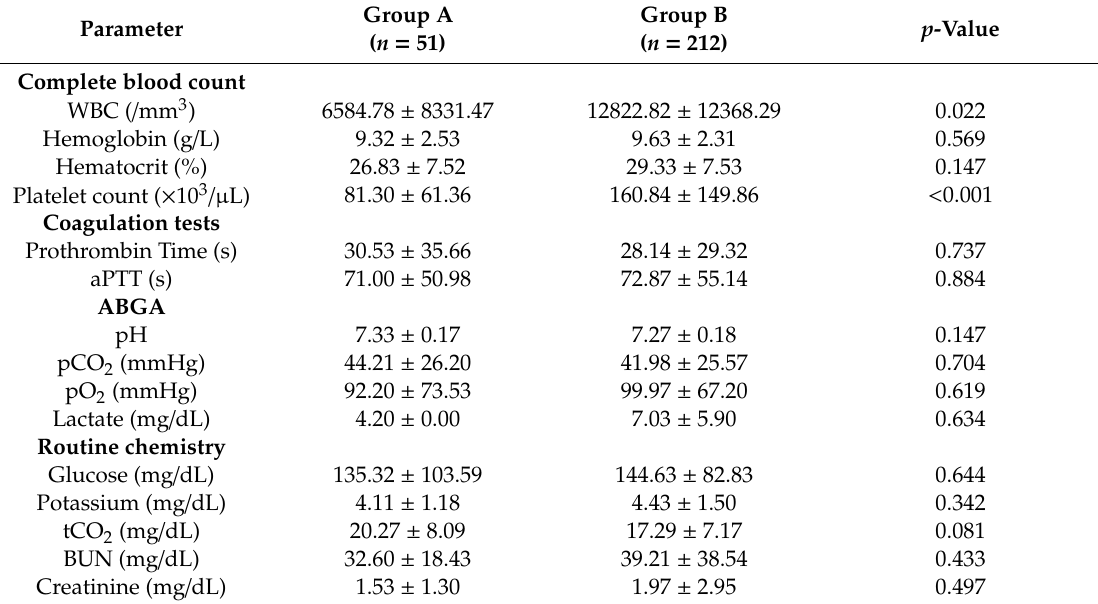
Table 4. Laboratory results of patients receiving